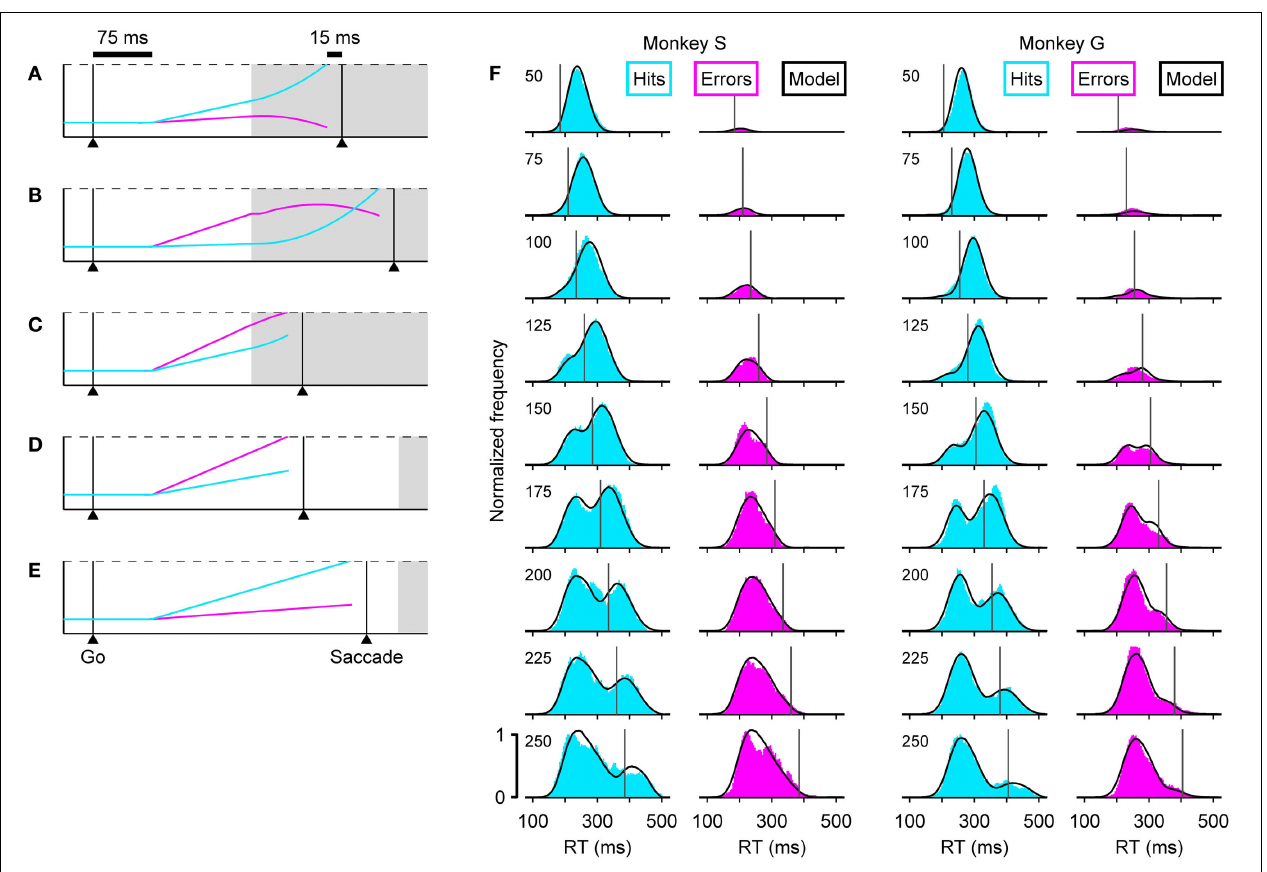
FIGURE 3 | The accelerated race-to-threshold model closely reproduces psychophysical data in the compelled-saccade task. (A–E) Simulated trials illustrating the five essential types of interaction between competing motor plans. In each panel, two competing variables represent oculomotor activity that triggers an eye movement either to the right (cyan) or to the left (magenta). In these examples the target is on the right, so races in which the cyan trace reaches threshold first correspond to correct choices. The two variables start racing 75ms (afferent delay) after the go signal and a saccade is triggered 15ms (efferent delay) after threshold is crossed. Initial build-up rates are drawn randomly in each trial. Gray shades indicate the time during